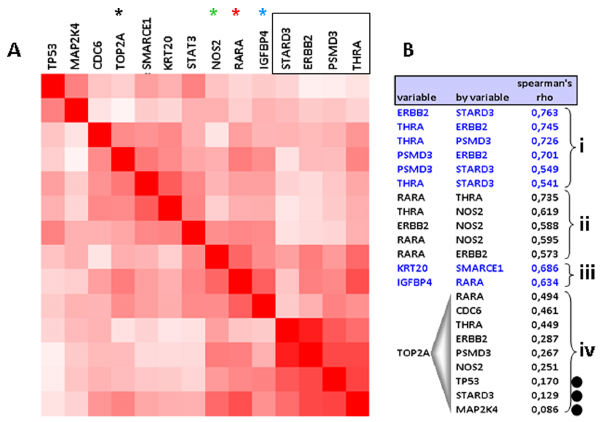
Figure 2. Correlations of log transformed copy number (CN) values. A: correlation map (clustered). B: Significant Spearman’s rho ( i, ii, iii ) and TOP2A correlations ( iv ). Except for those marked with a black dot in B, all other correlations yielded p values ,